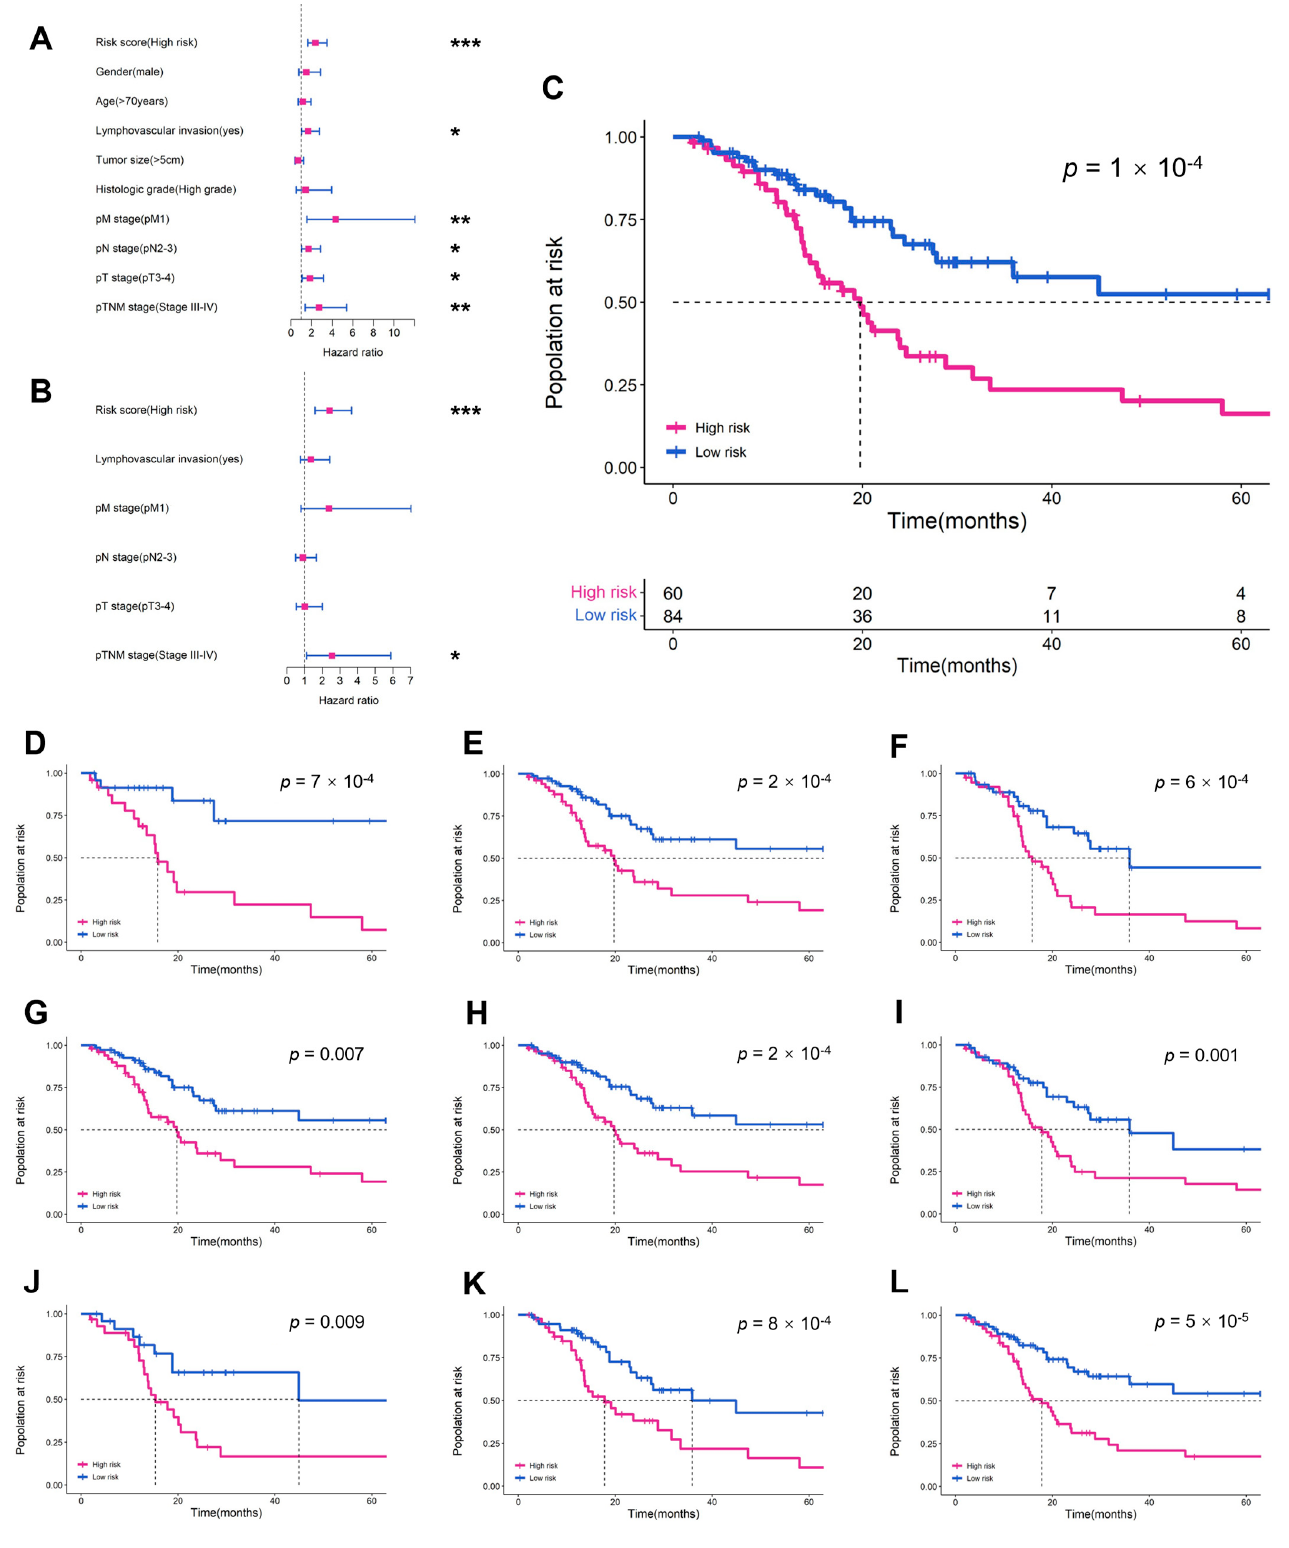
Figure 3. The performance of MibcMLP in predicting prognosis in the external validation set. ( A ) univariate Cox and ( B ) multivariate Cox analyses are exhibited. Using the median risk score in the training set as the cut-off point, ( C ) K-M survival curves for the entire external validation set and the following subgroups: ( D ) age ≥ 70; ( E ) male; ( F ) pT stage 3–4; ( G ) pN stage 0–1; ( H ) pM stage 0;